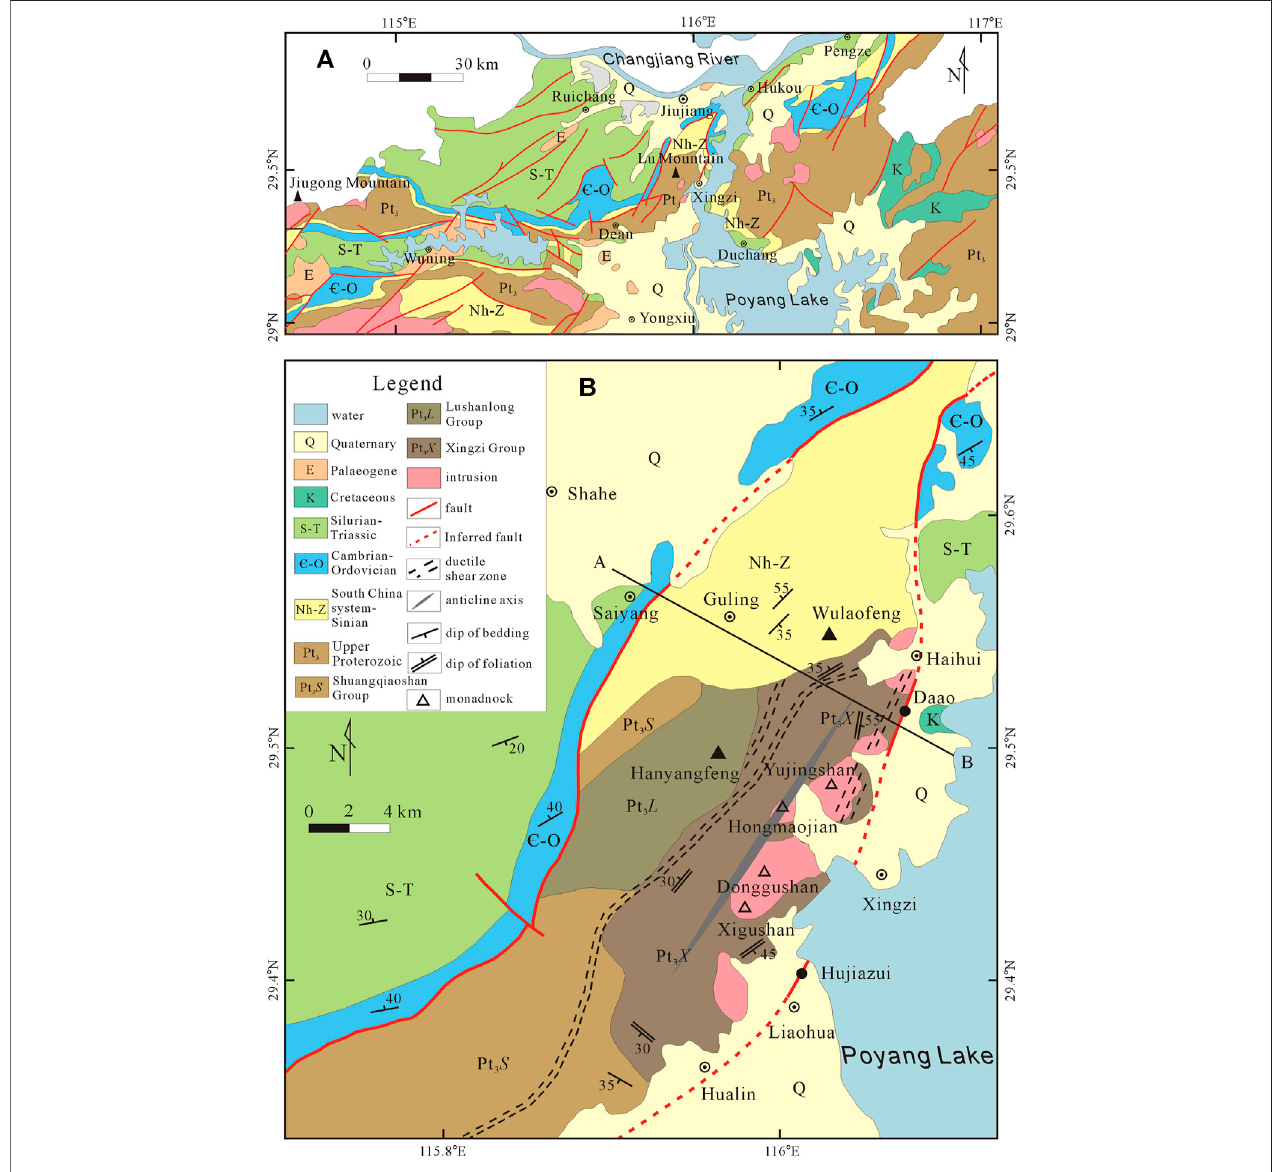
FIGURE 2 | Simpli fi ed geological map (A) Regional geological map modi fi ed after the geological map of Jiangxi Province (Ma, 2002). (B) Geological map of Lu Mountain (modi fi ed after the 1:50,000 geological maps produced by the Jiangxi Bureau of Geology and Mineral Resources in 1993 and 1995). Line A-B indicates the position of the cross-section in Figure 7